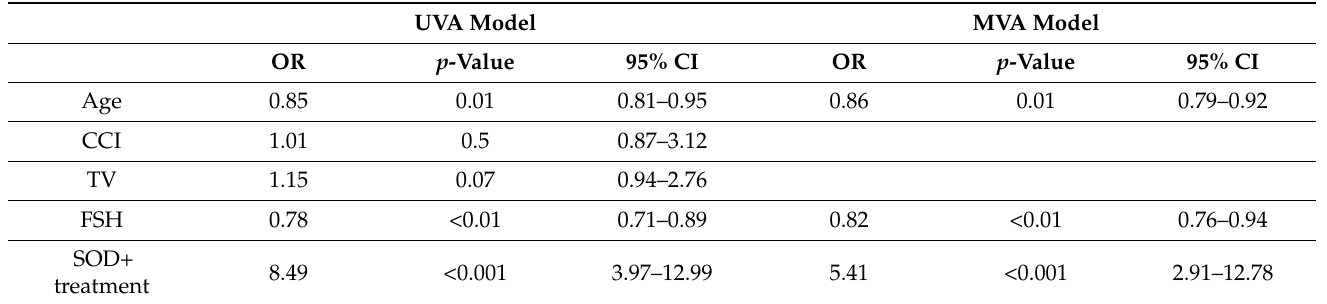
Table 3. Logistic regression models predicting SDF improvement >20% in the whole cohort (no. =